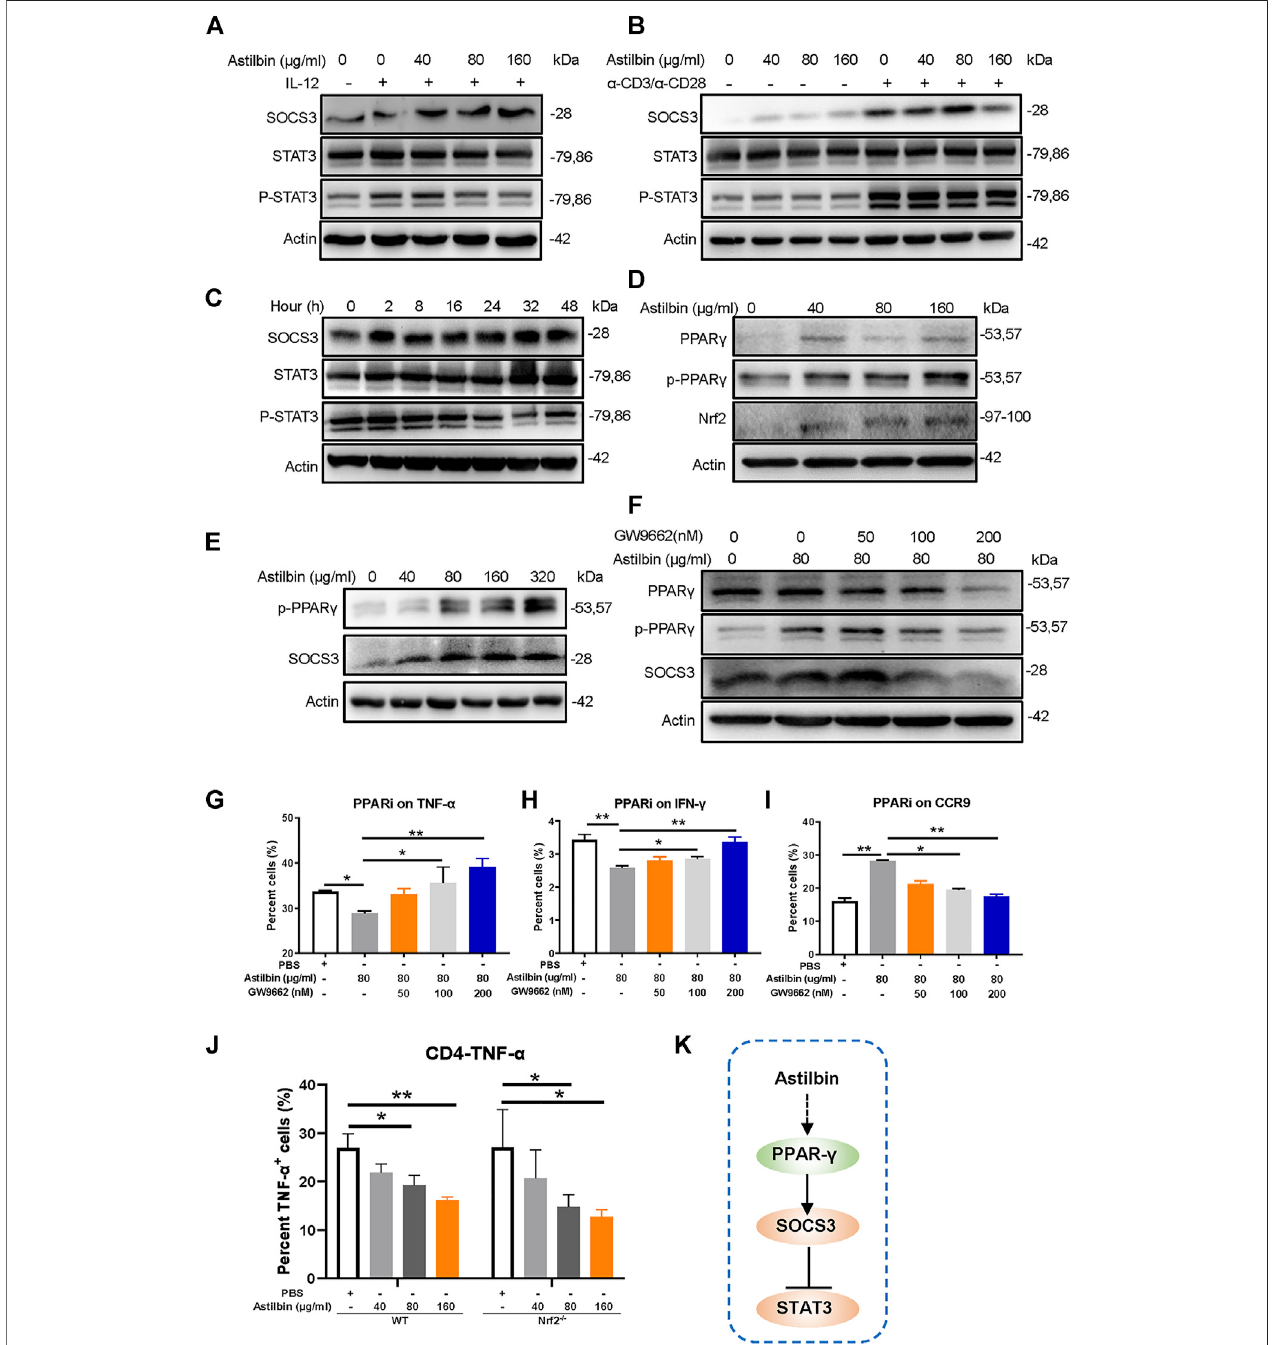
FIGURE 2 | PPAR γ /SOCS3 pathway in astilbin-treated CD4 + T cells. Effects of astilbin on the expression of SOCS3 and STAT3/p-STAT3 of unstimulated, IL-12- (A) ,or α -CD3/ α -CD28 − (B) stimulatedCD4 + TcellsbyWesternblotanalysis. (C) Effectsof80 μ g/mlastilbinonSOCS3andSTAT3/p-STAT3ofactivatedCD4 + Tcellsat differenttimepoints. (D) VariationsofPPAR γ /p-PPAR γ andNrf2inastilbin-treated CD4 + Tcells. (E) Parallelexpression ofp-PPAR γ and SOCS3inastilbin-treatedCD4 + T cells. (F) Inhibiting PPAR γ by GW9662 decreased SOCS3 expression. Effects of GW9662 on TNF- α (G) , IFN- γ (H) , and CCR9 (I) expression in astilbin-treated CD4 + T cells. Mean ±SD; n = 3. (J) TNF- α production of astilbin-treated Nrf2 − / − CD4 + T cells. Mean ± SD; n = 3. (K) Diagram of PPAR/SOCS3pathway on CD4 + T cells by astilbin. Each experiment was repeated at least three times. The inhibitor of PPAR, GW9662, is abbreviated as PPARi. p values (* p ≤ 0.05; ** p ≤ 0.01) determined by one-way ANOVA (G – J) .